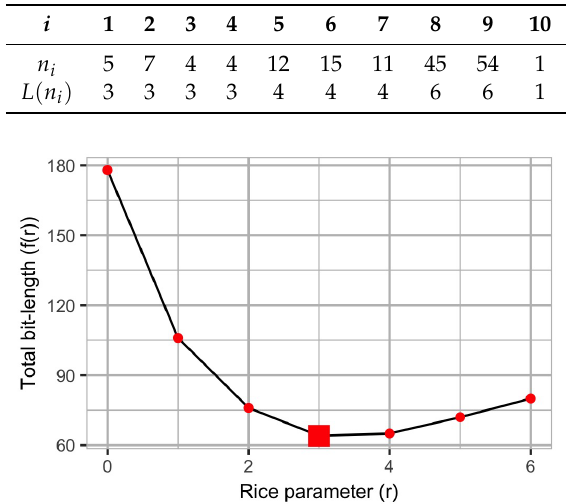
Figure 1. Number of bits used to encode randomly generated data by using different Rice parameters r ∈ [ 0,6 ] for the input data sequence presented in Table 1. The total bit-length function f ( r ) is only defined for integer values of r (marked with dots and squares in the figure). A continuous line was added between the points to improve